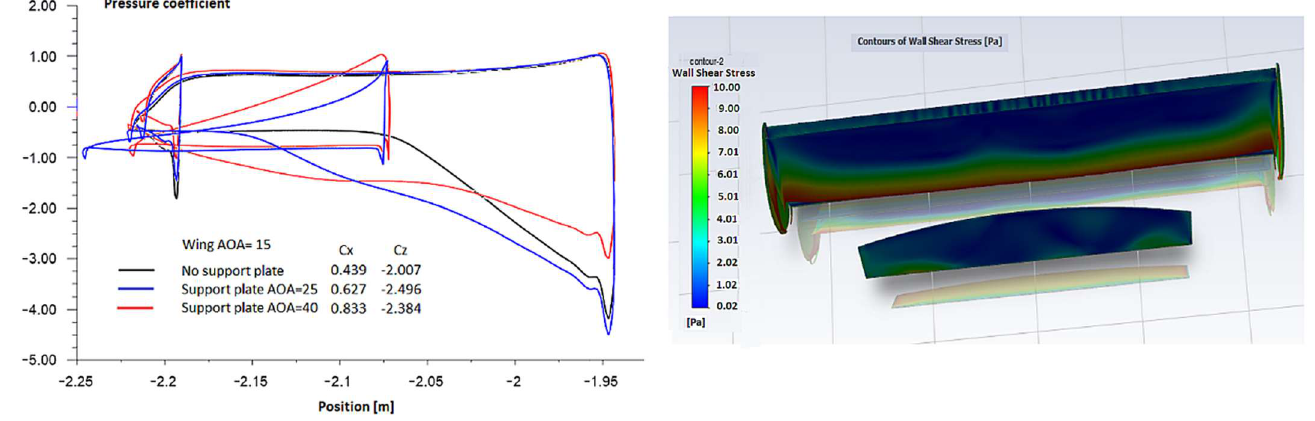
Figure 19. Pressure distributions on the upper and lower surfaces of the wing in its plane of symmetry and on the lower surface.